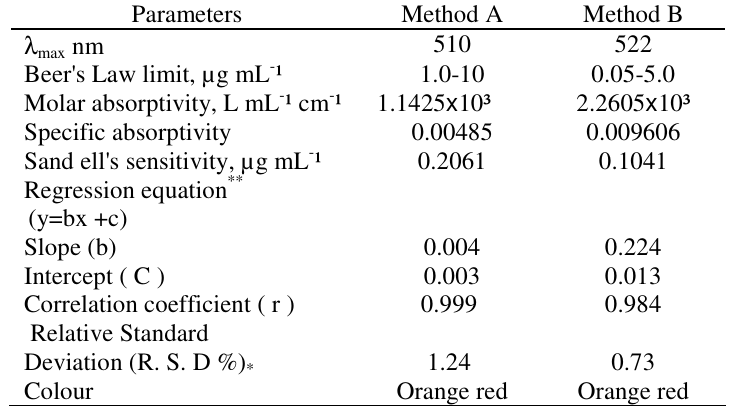
Table 1. Optical characteristics and validation data of spectrophotometric